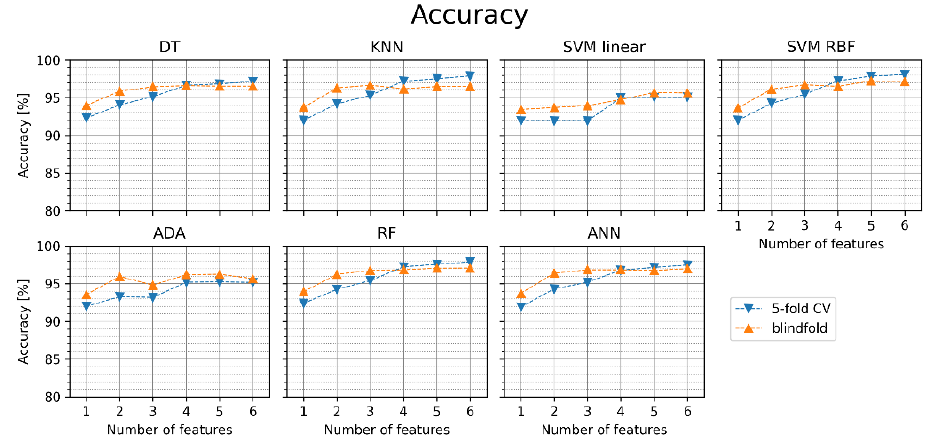
Figure 5. Accuracy of AF detection for different classifiers with sets of one to six features (orange points—blindfold validation, blue points—5-fold cross-validation). DT—decision tree, KNN—K nearest neighbors, SVM linear—support vector machine with linear kernel, SVM RBF—support vector machine with radial basis function kernel, ADA—Ada Boost, RF—random forest, ANN—artificial neural network.